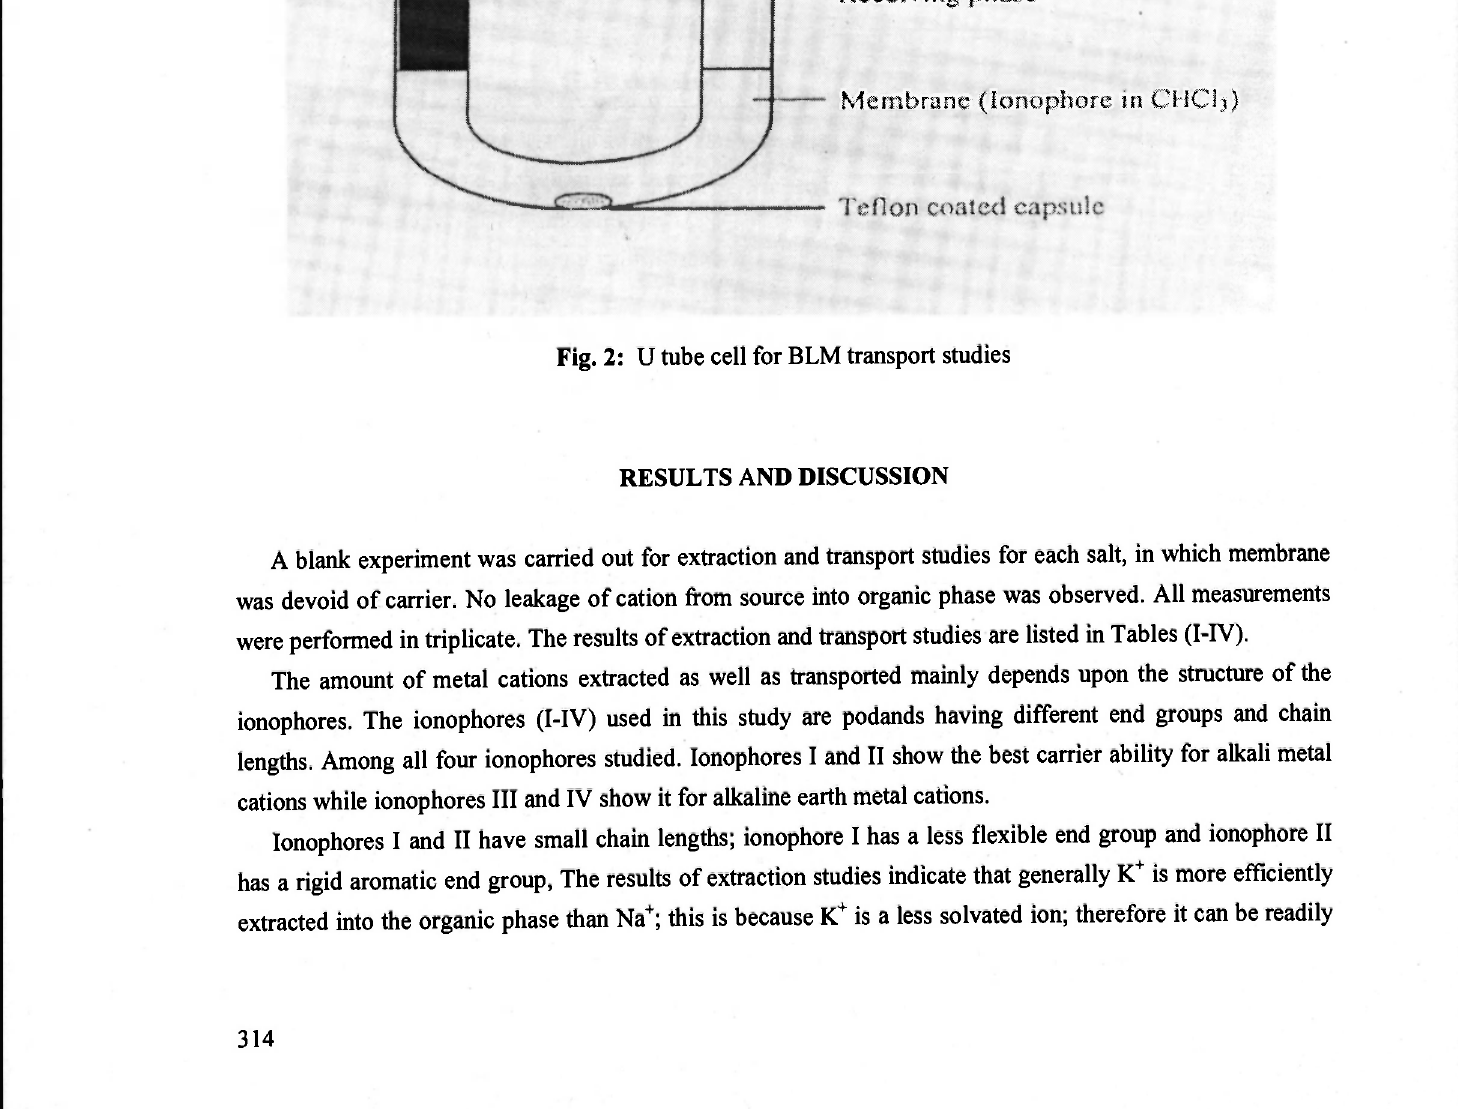
Fig. 2: U tube cell for BLM transport